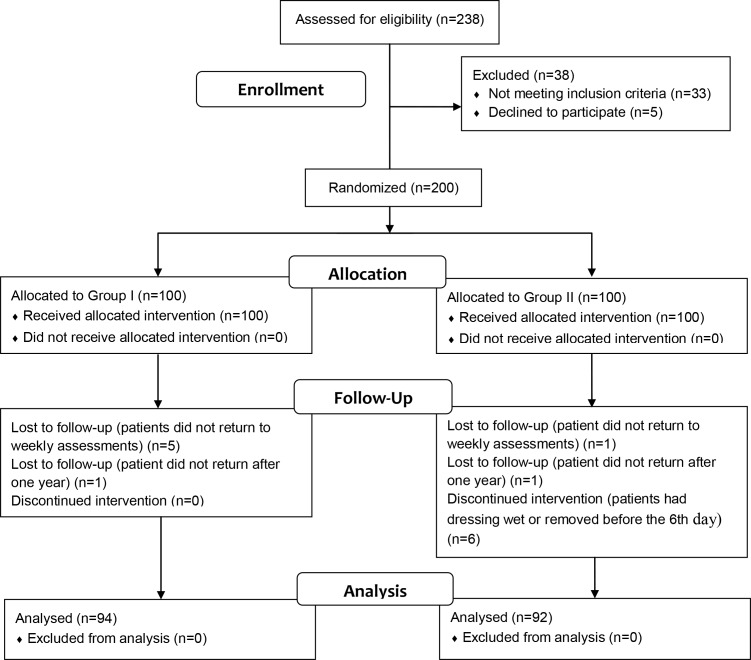
CONSORT Flow Diagram [43]